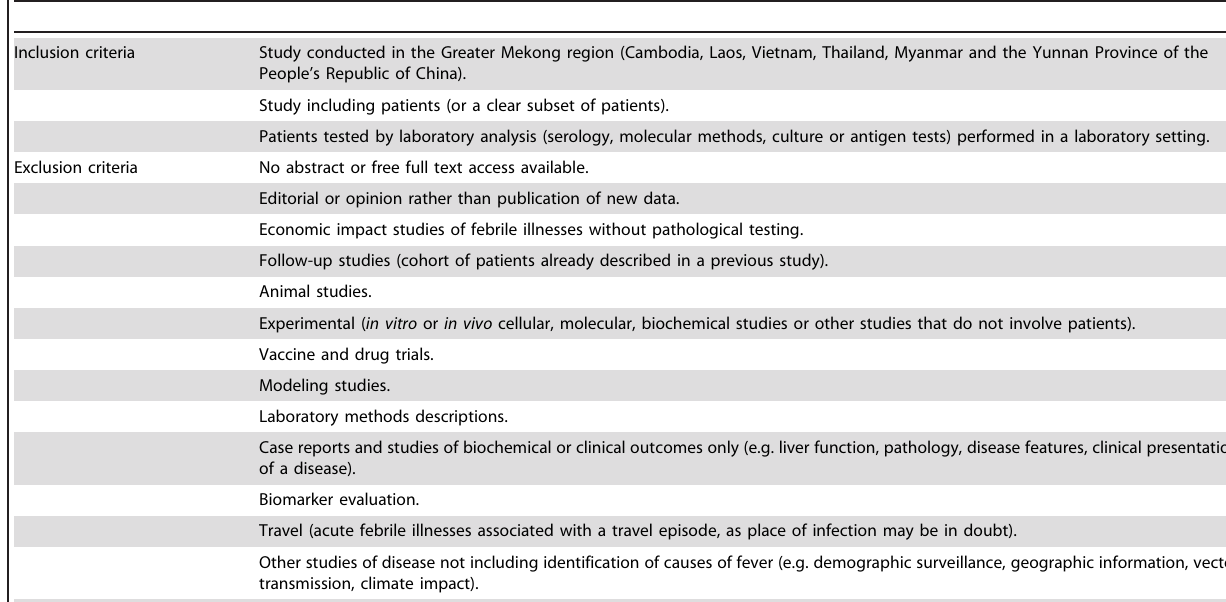
Table 1. Criteria used for selection of papers for the mapping of aetiology of non-malaria febrile illness in Southeast Asia.